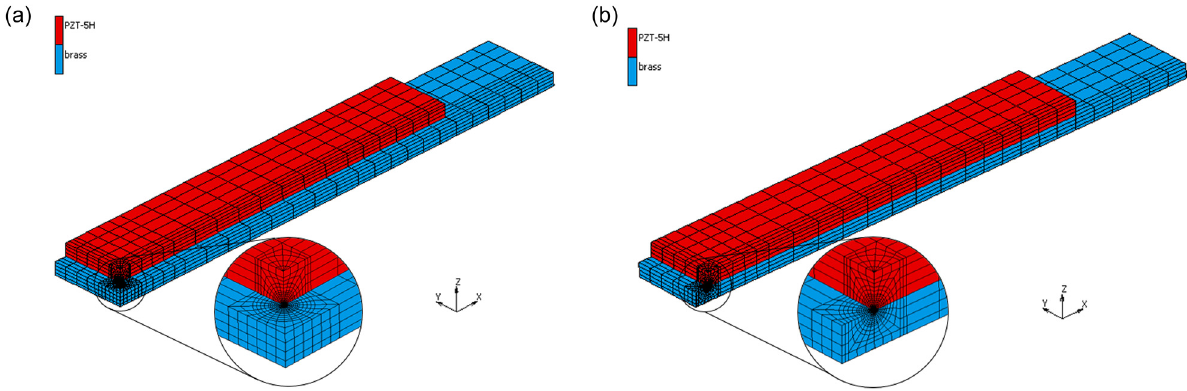
Figure 3: The FE models used to obtain the displacements and the electric potentials: ( a ) Vertex - 1 and ( b ) Vertex -